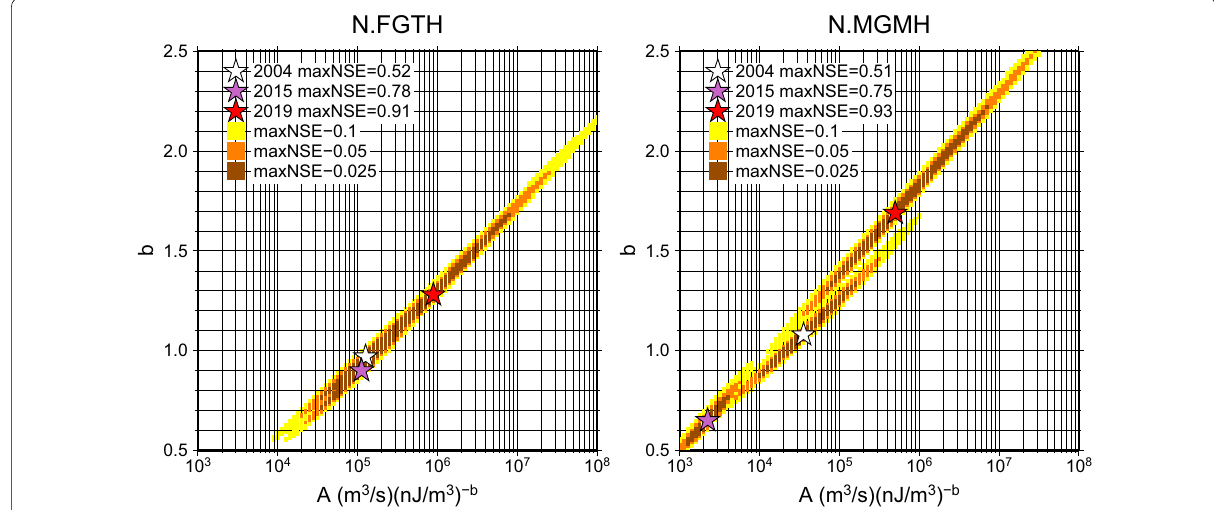
Fig. 8 Best-fit A and b values and their uncertainty ranges. Stars show the best-fit values that maximize the NSE value. Colored areas represent regions with relatively high NSE values; that is, NSE values are higher than the maximum NSE value minus 0.1 (yellow), 0.05 (orange), and 0.025 (brown). Colored areas for different events partly overlap